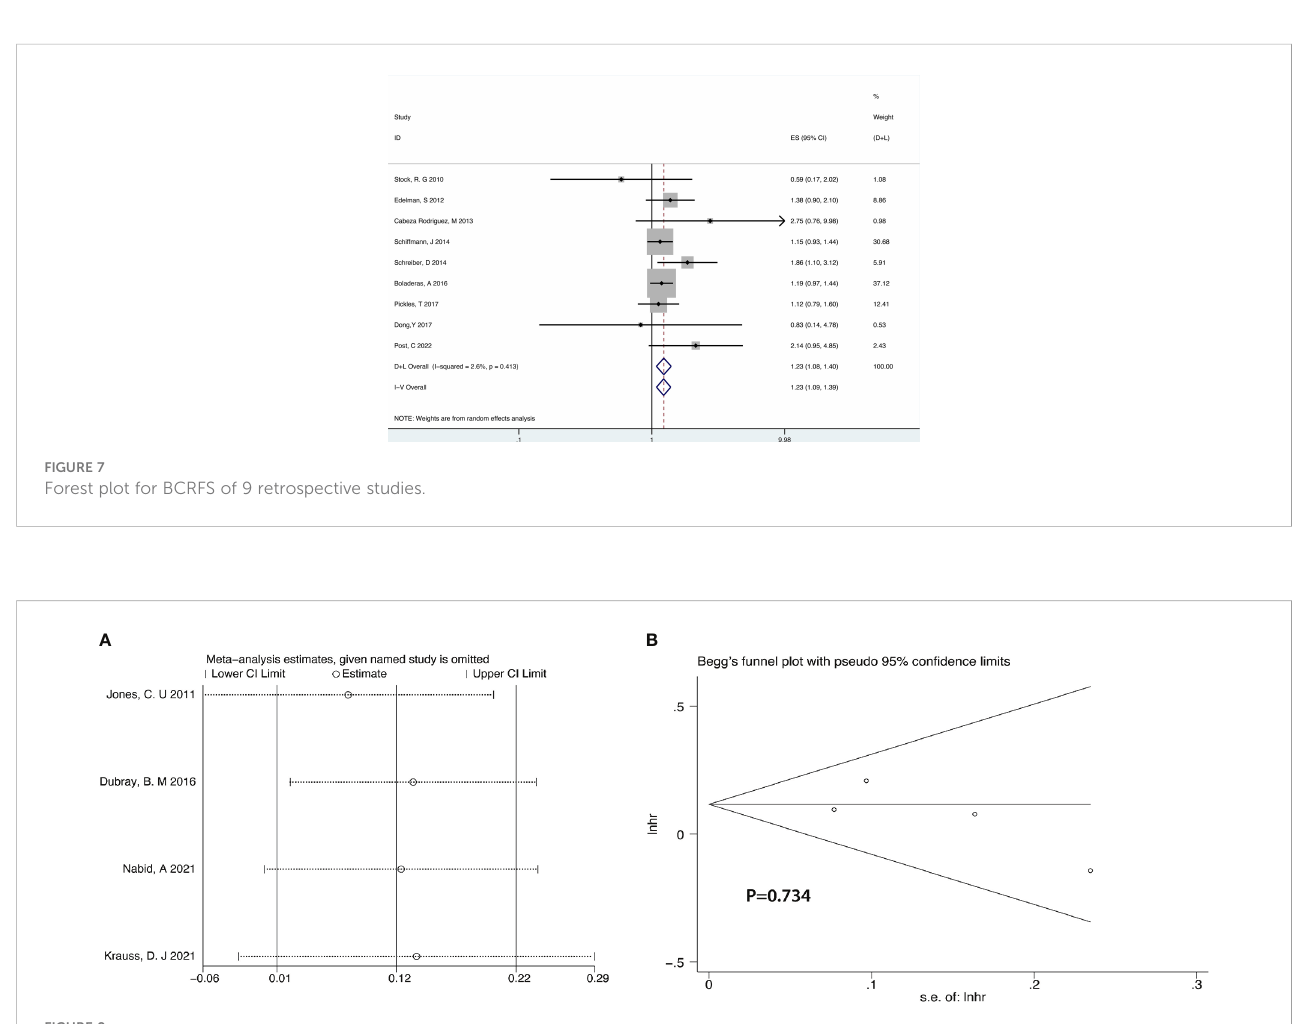
FIGURE 8 Sensitivity analysis (A) and Begg ’ s funnel plot (B) for OS of 4